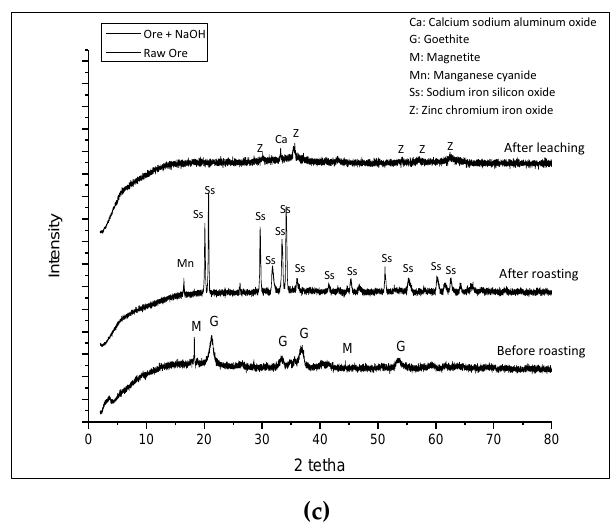
Figure 6. XRD patterns of ( a ) Ore + Na 2 CO 3 , ( b ) ore + Na 2 SO 4 and ( c ) ore + NaOH after roasting and leaching with SO 2 –air .